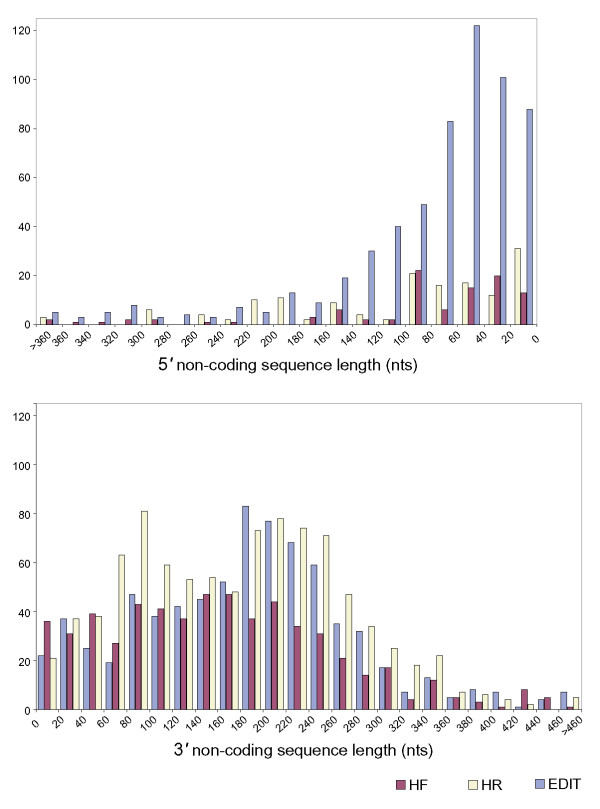
Length of 5' and 3' non-coding sequences. Protein translations of the SSH sequences in each library were mapped by BLASTX to the most homologous plant protein in GenBank. The histogram depicts the number and size of SSH sequences predicted to extend into either the 5' or 3' non-coding regions.